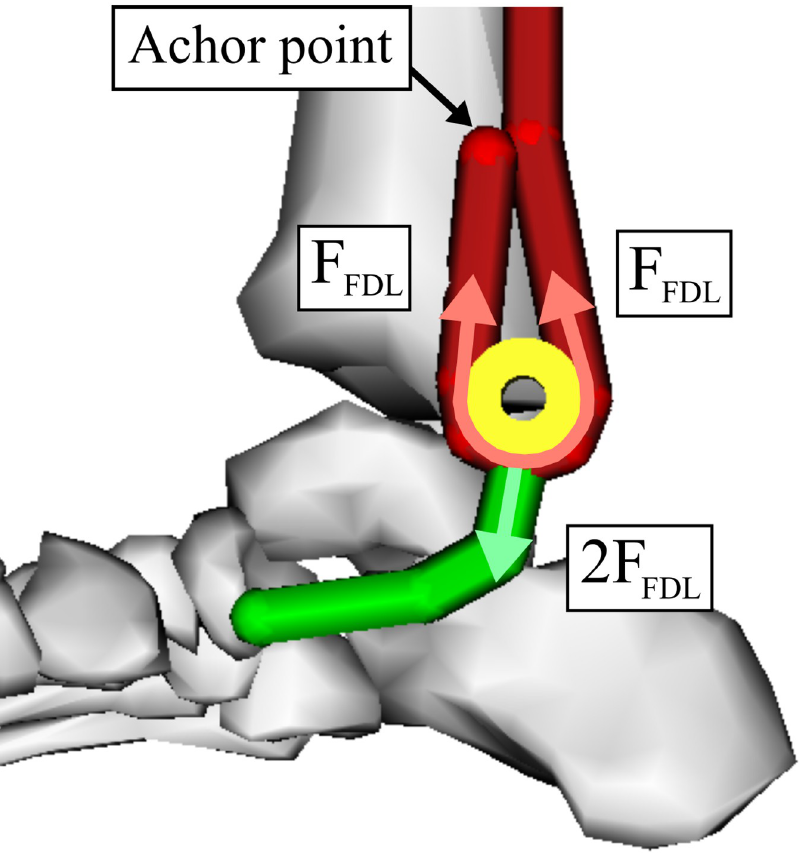
Fig 5. Diagram of the force amplification created by the implant-based tendon transfer surgery. The tendon network created by the implant forms a pulley system that amplifies the force generated by the transferred flexor digitorum longus muscle as it is routed to the navicular